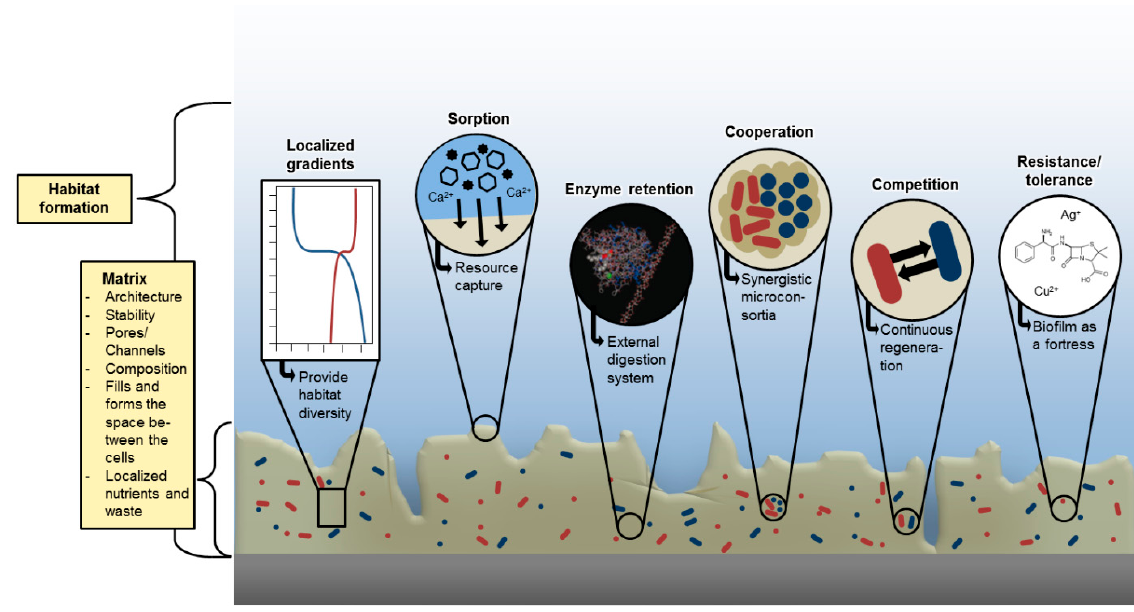
Figure 4. Properties of biofilms emerging from life in the EPS matrix (after [19], with permission).